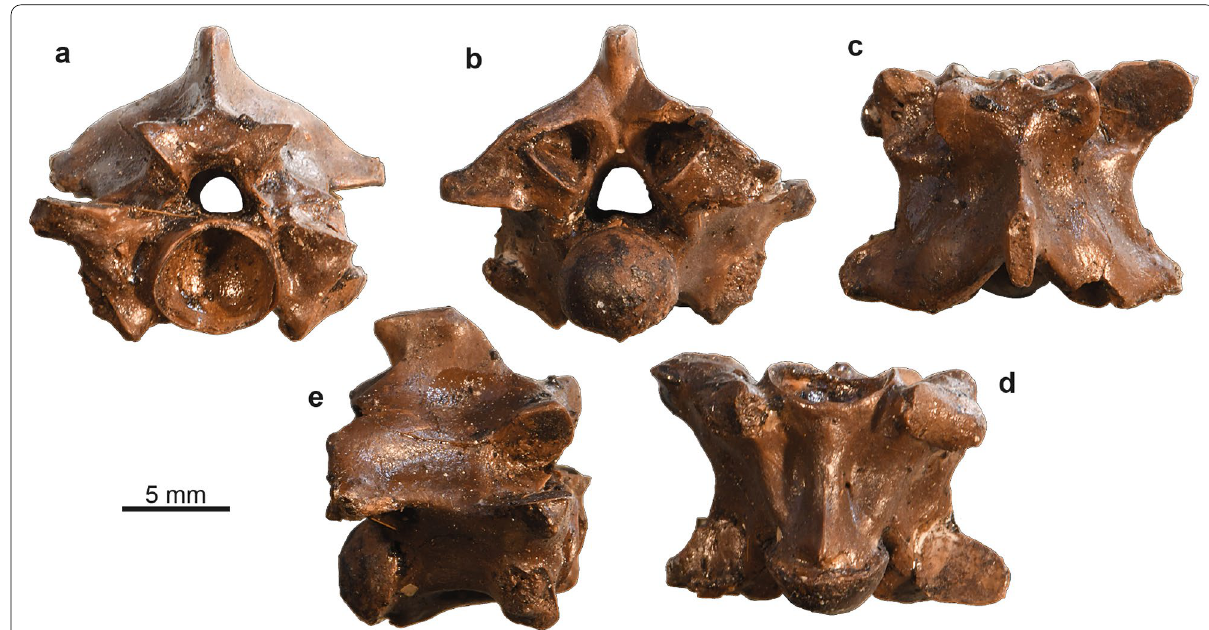
Fig. 62 Eoconstrictor cf. fischeri from quarry XXXVII, Geiseltal: posterior mid- or posterior trunk vertebra (GMH XXXVII-179a-1970) in anterior ( a ), posterior ( b ), dorsal ( c ), ventral ( d ), and right lateral ( e )